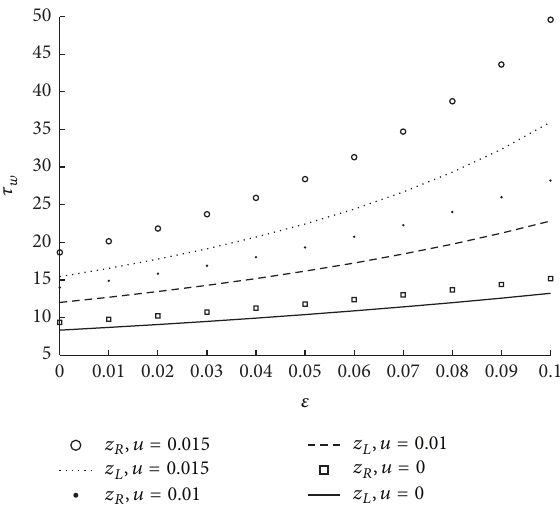
Figure 7: The variation of impedance with respect to 𝑢 when 𝑁 = = 0.1 , and 𝜙 = −0.05 . 0.75 , 𝑚 = 50 , Γ = 0.5 , 𝑟 𝑐